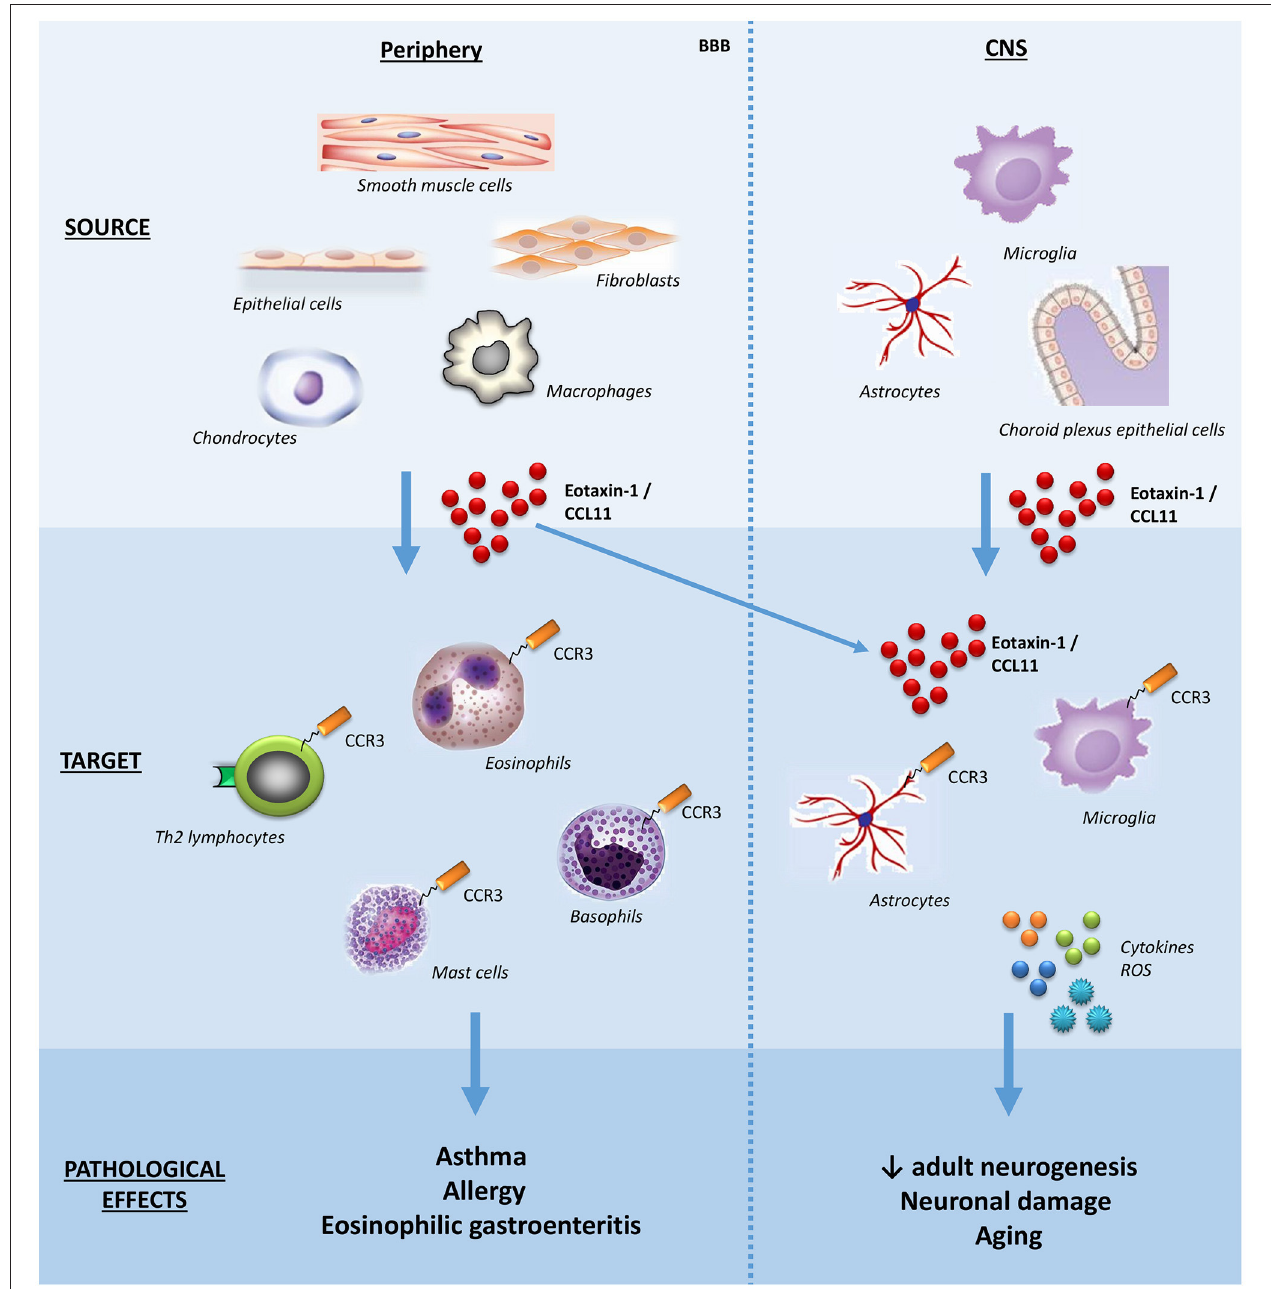
FIGURE 1 | Schematic effects of eotaxin-1/CCL11 in adult subjects. The main sources, targets, and effects of the chemokine eotaxin-1/CCL11 are shown both in peripheral tissues and CNS. Note that eotaxin-1/CCL11 is capable of crossing the BBB and influencing CNS cells. BBB, blood-brain barrier; CNS, central nervous system; ROS, reactive oxygen